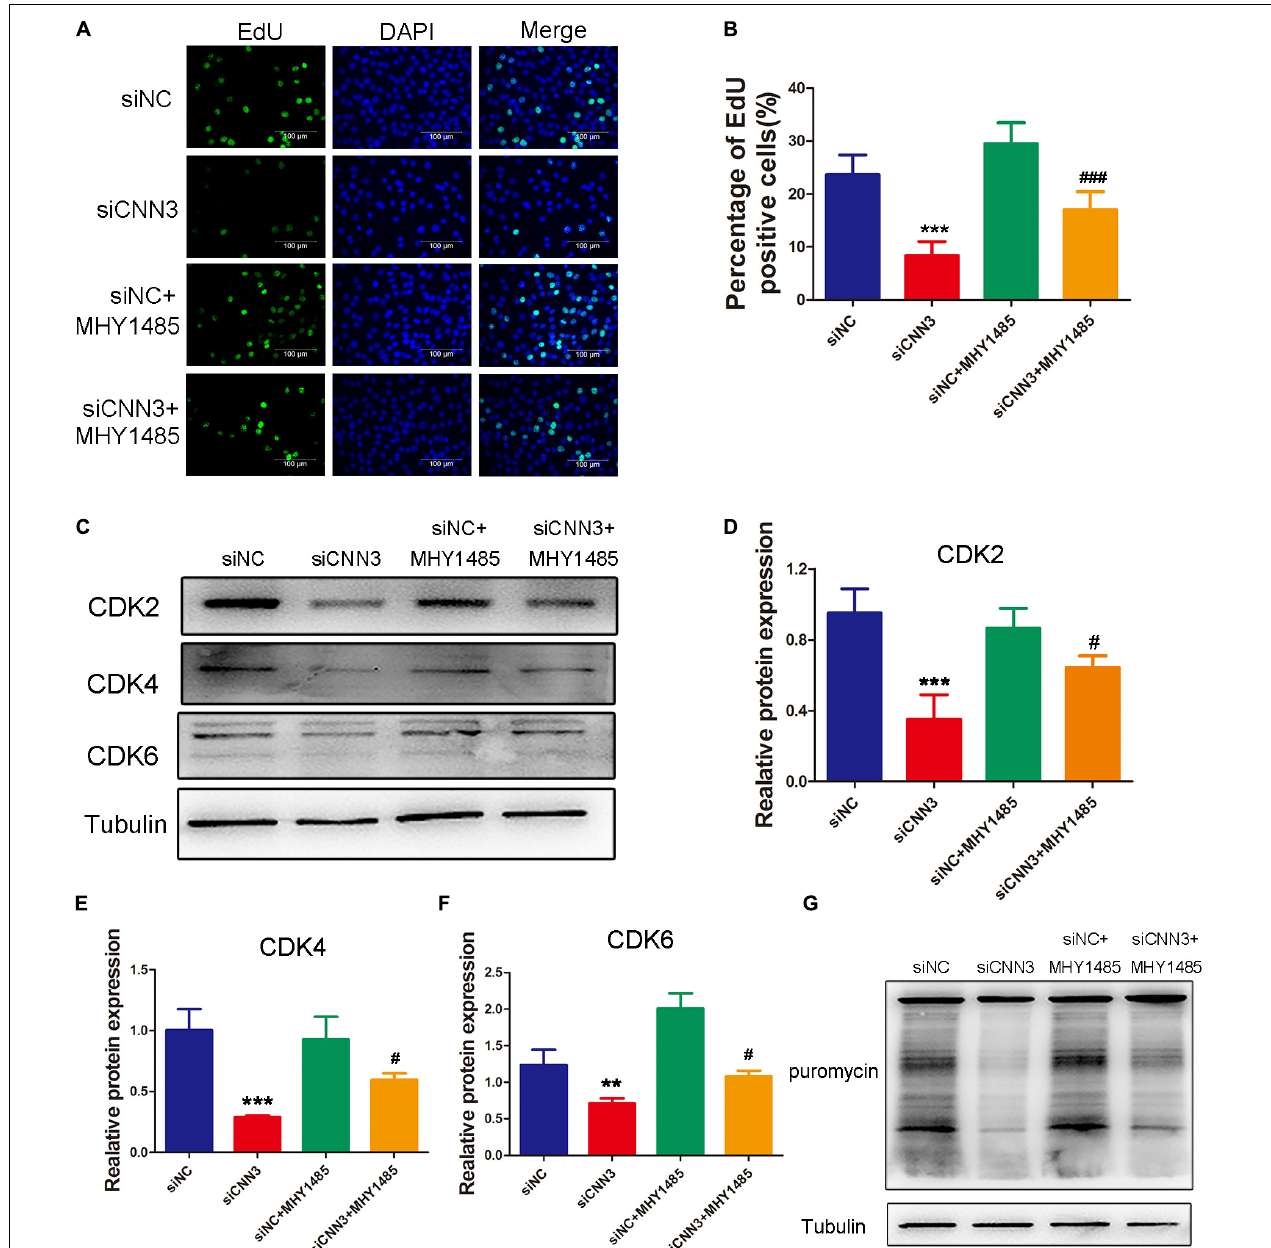
FIGURE 5 | MHY1485 treatment restored myoblast proliferation and protein synthesis in CNN3 knockdown cells. (A) Fluorescence images showing EdU-labeled cells to assess cell proliferation. The green color indicates EdU labeling, and the blue color indicates DAPI nuclear staining. (B) The percentage of EdU-positive cells among the total number of cells detected by DAPI nuclear staining. (C) Western blot analysis of CDK2, CDK4, and CDK6. (D–F) Quantification of the Western blot bands for (D) CDK2, (E) CDK4, and (F) CDK6 by Image J, using tubulin was used as the internal control. (G) Newly synthesized proteins detected by Western blot analysis using an anti-puromycin antibody. ** P < 0.01, *** P < 0.001 compared with the NC siRNA (siNC) group; # P < 0.05, ### P < 0.001 compared with the CNN3 knockdown (siCNN3)